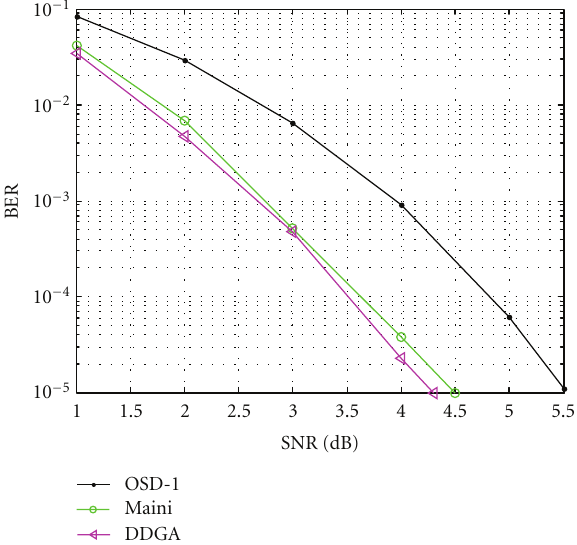
Figure 21: Performances of OSD-1, Maini, and DDGA for QR (103,52,19)